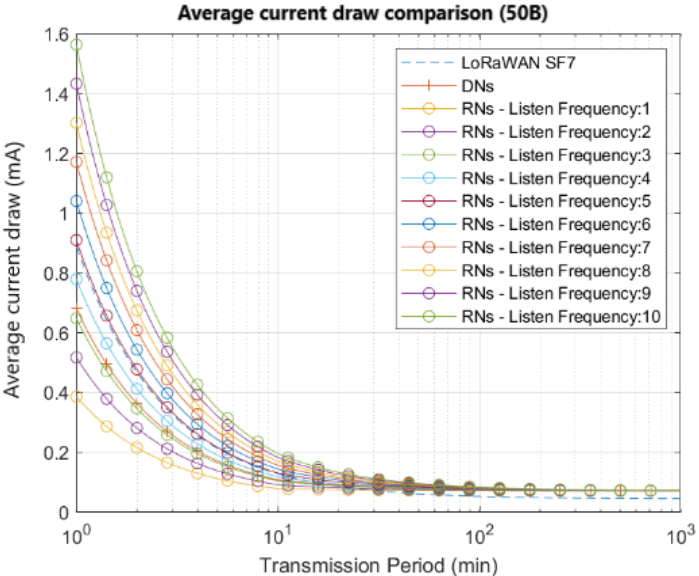
Figure 10. Average current draw in function of transmission period for applications with payloads of 50 bytes.